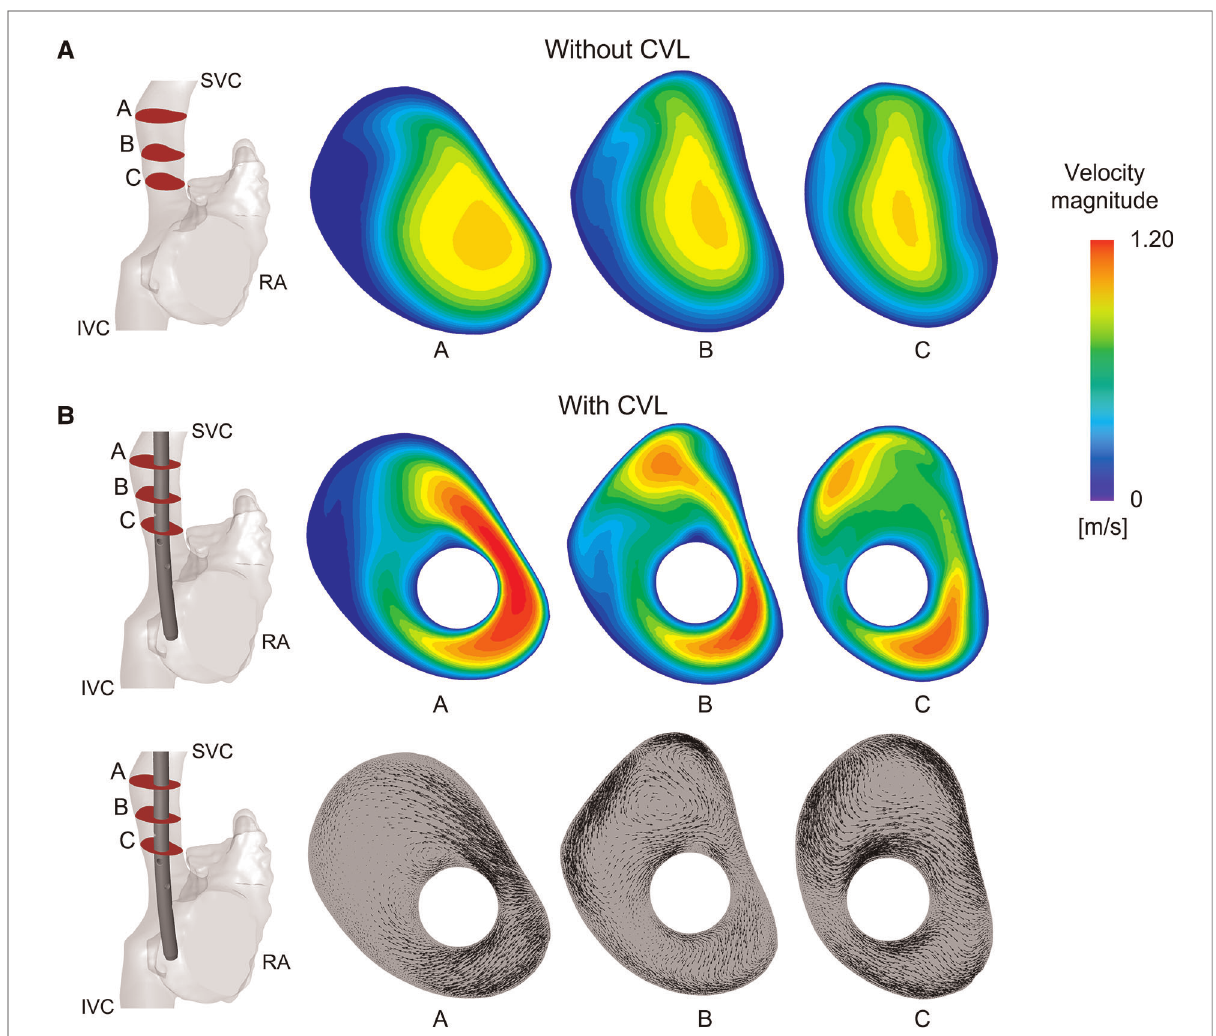
FIGURE 6 Velocity fi eld and vectors of the anatomical model with Tesio: ( A ) Velocity maps plotted at three different planes along the SVC without CVL; ( B ) Velocity maps and in-plane velocity vectors are plotted on planes after CVL insertion. CVL=Central venous